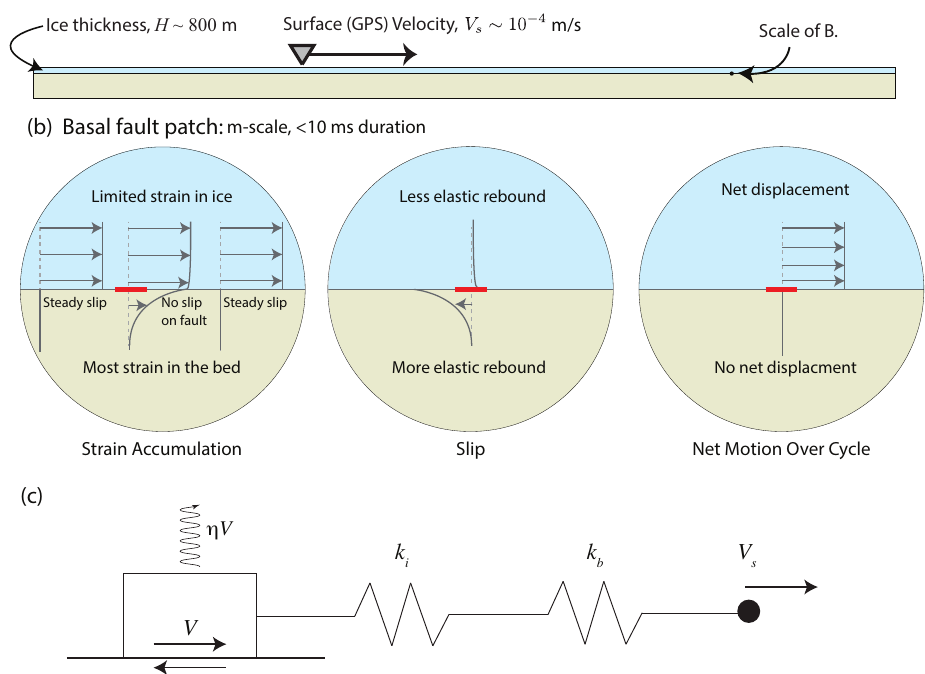
Figure 2. Schematic illustration showing the spatial and temporal scales of stick-slip motion in the Whillans Ice Plain (WIP). (a) The entirety of the WIP undergoes stick-slip motion with 100km extent. During this time, the ice slides with elevated velocity for approximately 30min duration. (b) During large-scale sliding, small repeating earthquakes happen with duration less than 10ms on fault patches with radius ∼ 1m. The tremor-producing patch is shown as a red bar, and the arrows represent particle displacements. Through our analysis we infer a compliant bed which implies that more motion occurs in the till than in the ice at the scale of the tremor patch. (c) Diagram of a mechanically analogous system showing the load point velocity, two springs in series, a frictional element, and the damping effect of radiated seismic waves. The ice and bed stiffnesses, k i and k b , are discussed in Sect.